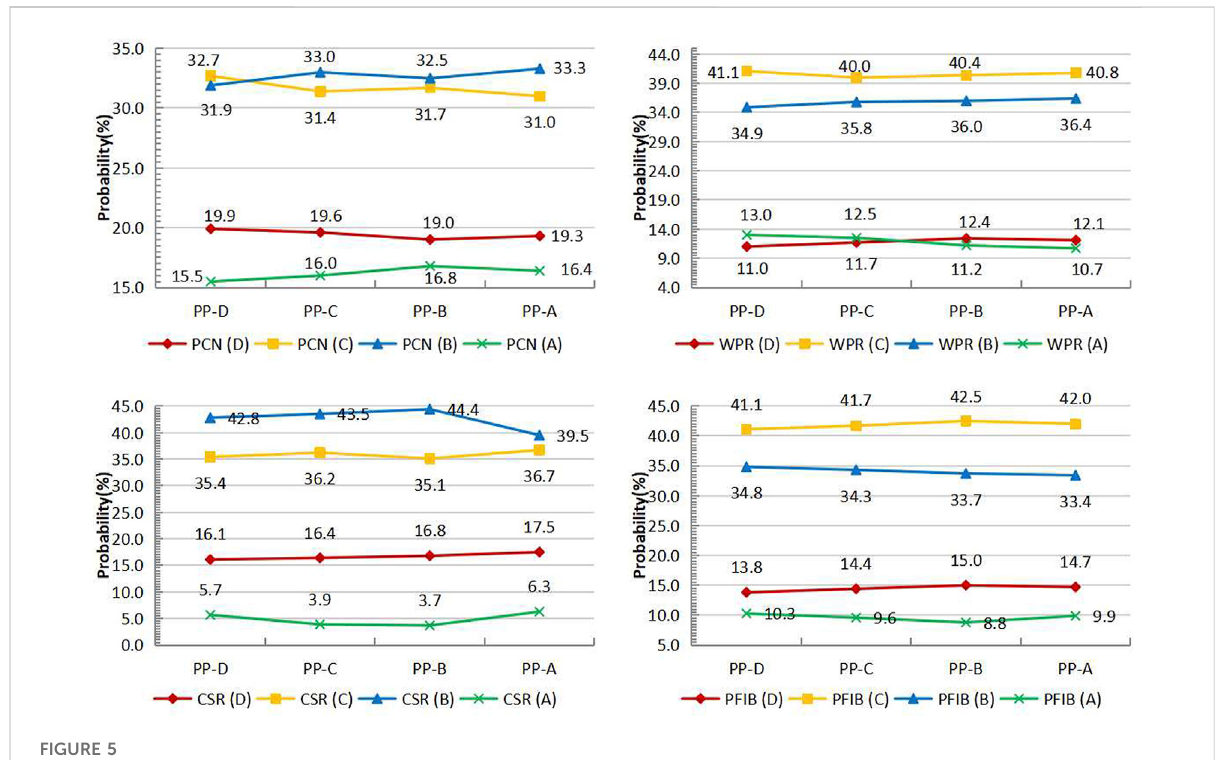
FIGURE 5 Changes in the PCN, WPR, CSR, and PFIB nodes.